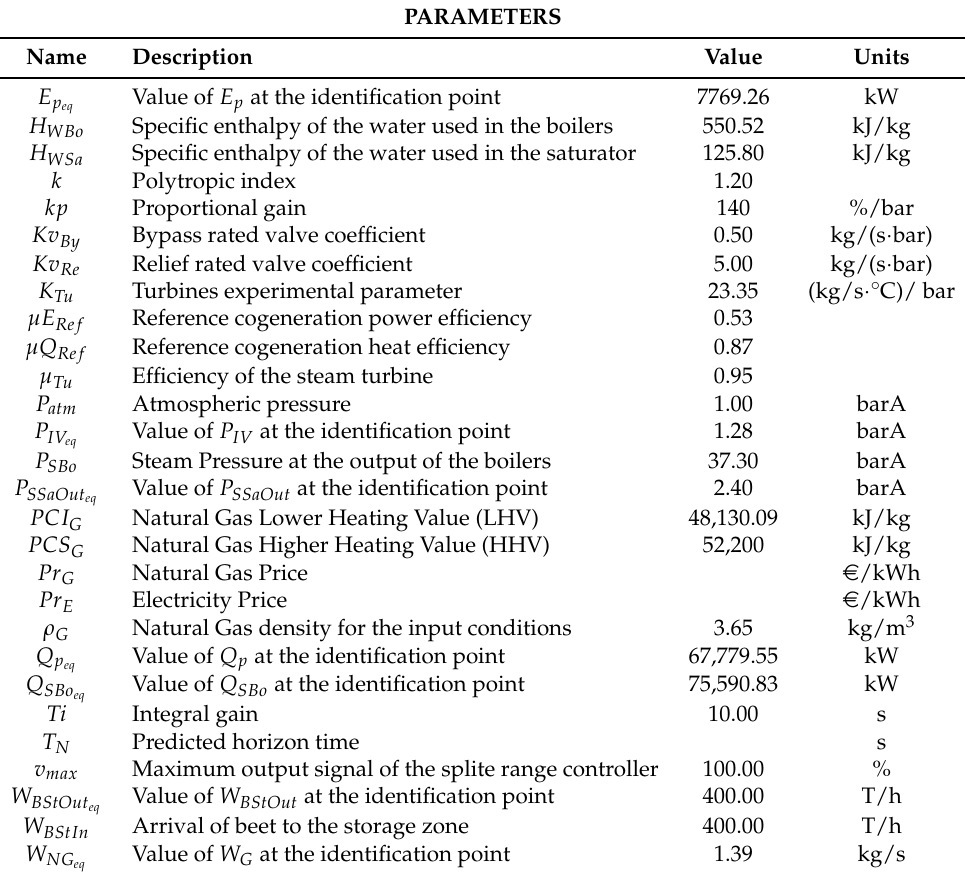
Table A2. Parameters value and